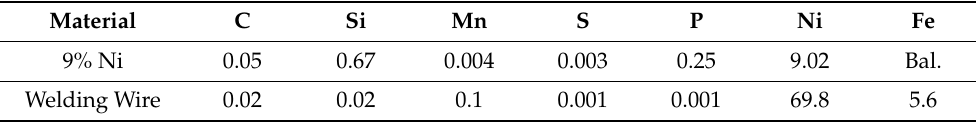
Figure 1. Equipment and process of flux-cored arc welding. ( a ) Experimental setup for flux-cored arc welding. ( b ) Flux-cored arc welding process. Table 1. Chemical composition of 9% Ni steel. (wt.%)